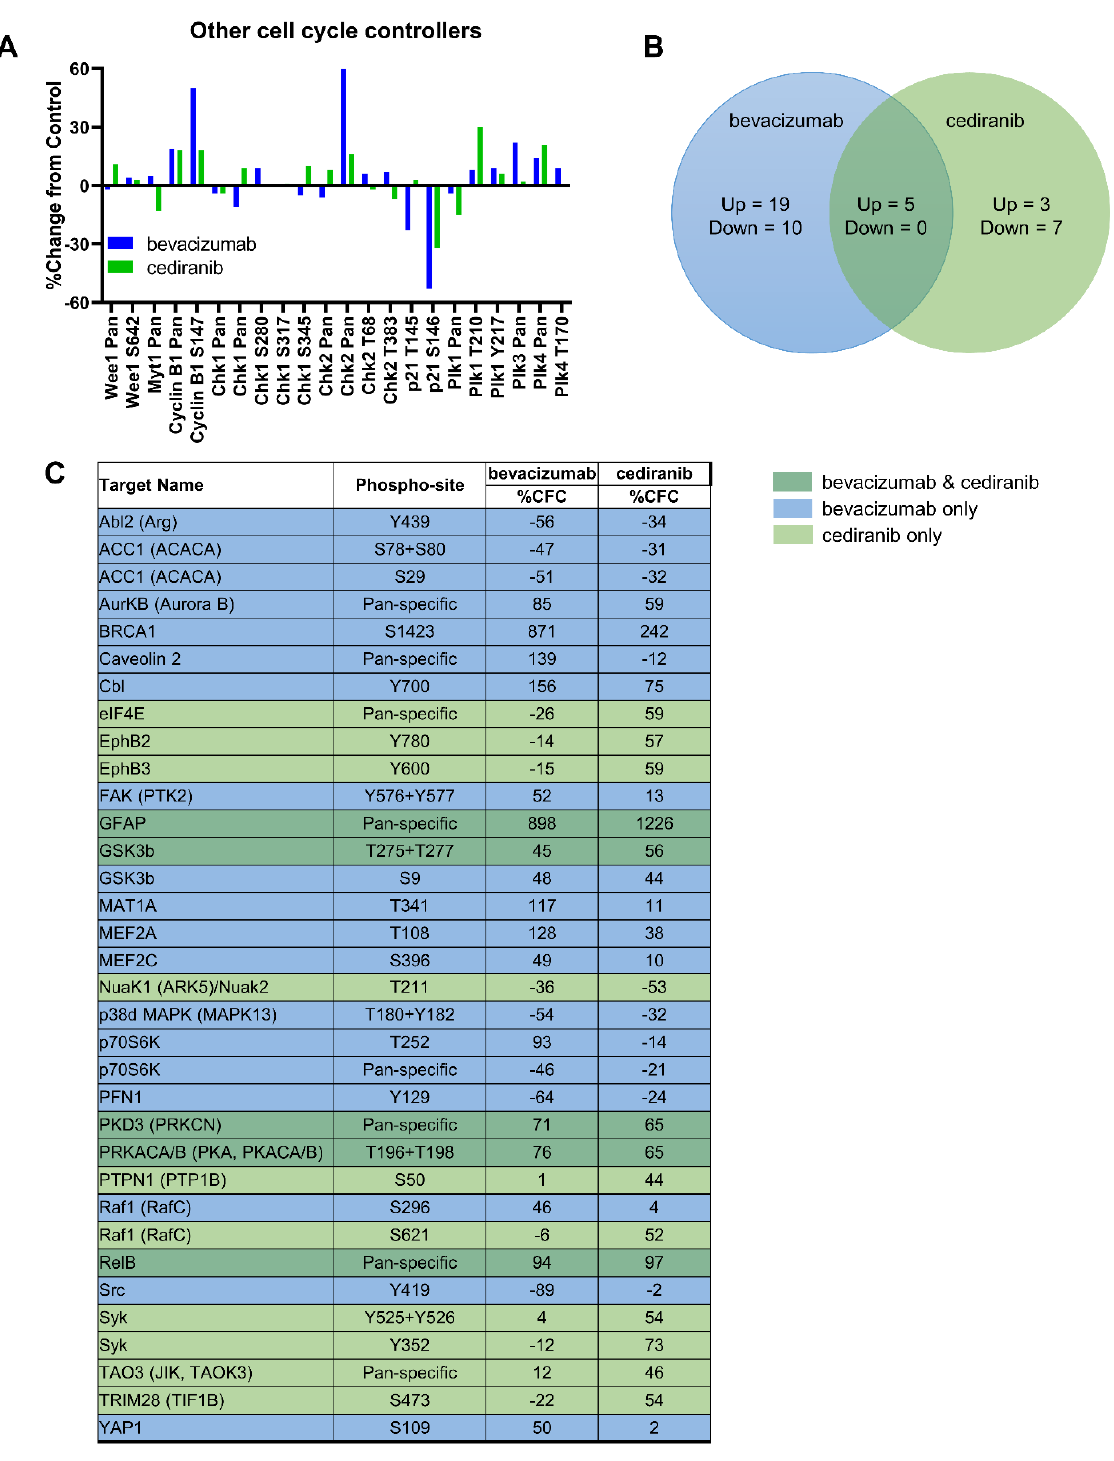
Figure 6. Bevacizumab regulates more signaling events than cediranib in endometrial cancer cells . Signaling events in response to single-agent bevacizumab or cediranib were analyzed by Kinex™ KAM-1325 Phosphproteomic Antibody Microarray after treatment of Hec50 cells with 1 µ M bevacizumab or 1 µ M cediranib for 24 h. ( A ) Depiction of changes in select cell cycle controllers. Data were calculated as the percent change from control (%CFC); “pan” indicates total protein expression. ( B ) Venn diagram of lead candidates in response to either bevacizumab or cediranib. Overlap indicates signaling events that were shared between the two treatment groups. Up = increased expression/phosphorylation; down = decreased expression/phosphorylation. ( C ) Table of all lead candidates identified based on the %CFC [28]. Negative %CFC indicates a decrease as compared to control. Full results are provided as Supplemental Table S2.